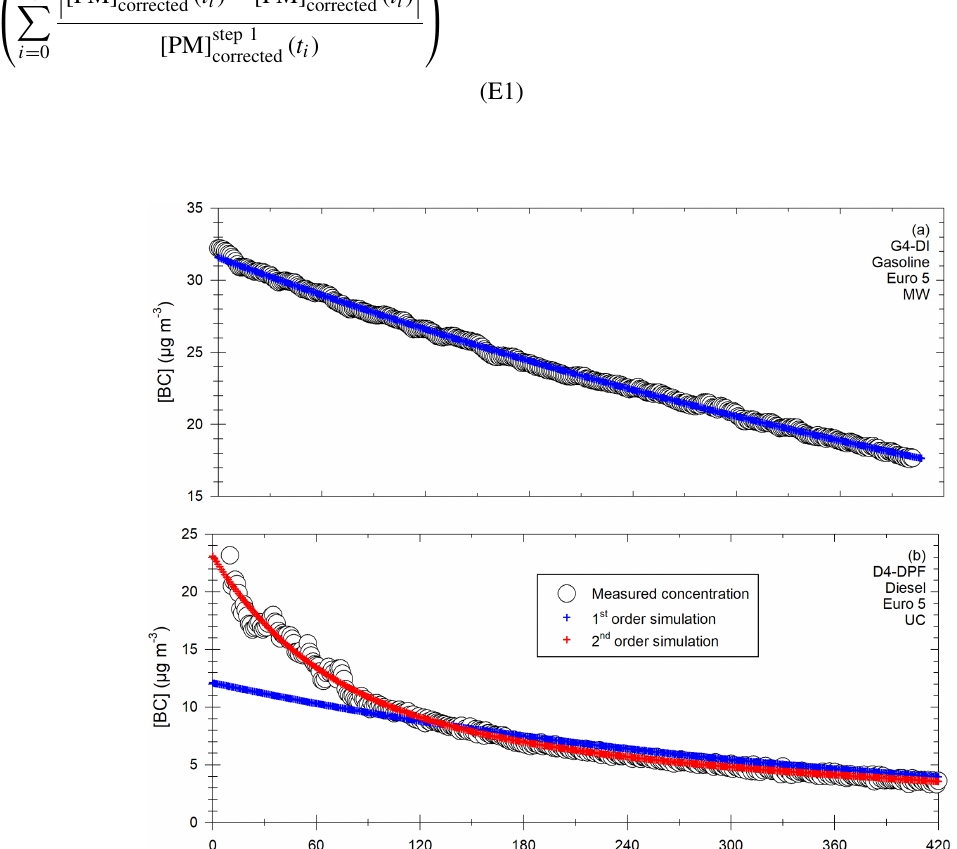
Figure D1. Evolution of the measured BC concentration (white circles) for the G4-DI vehicle under MW conditions (a) and the D4-DPF vehicle under UC conditions (b) . The curve is fitted with a first-order exponential decay (blue) in both cases and with a second-order exponential decay (red) in panel (b)